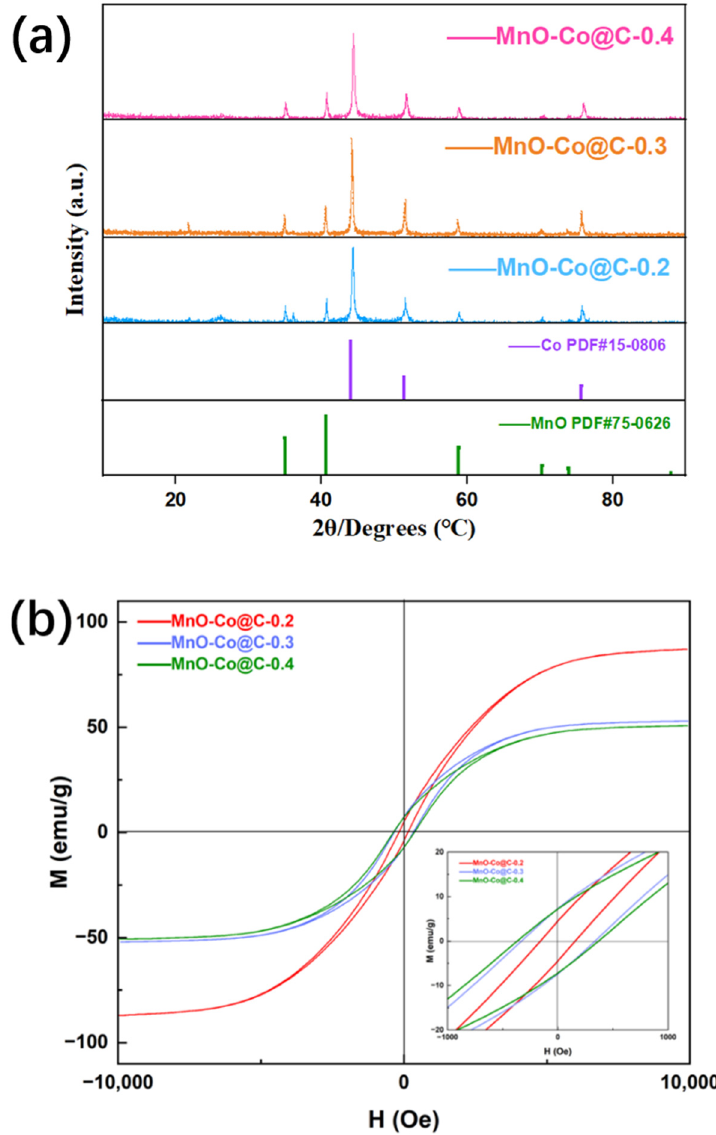
Figure 3. ( a ) The XRD pattern of MnO-Co@C-0.2, MnO-Co@C-0.3, and MnO-Co@C-0.4, ( b ) hysteresis loops of MnO-Co@C-0.2, MnO-Co@C-0.3, and MnO-Co@C-0.4. The hysteresis lines of MnO-Co@C-0.2, MnO-Co@C-0.3, and MnO-Co@C-0.4 are